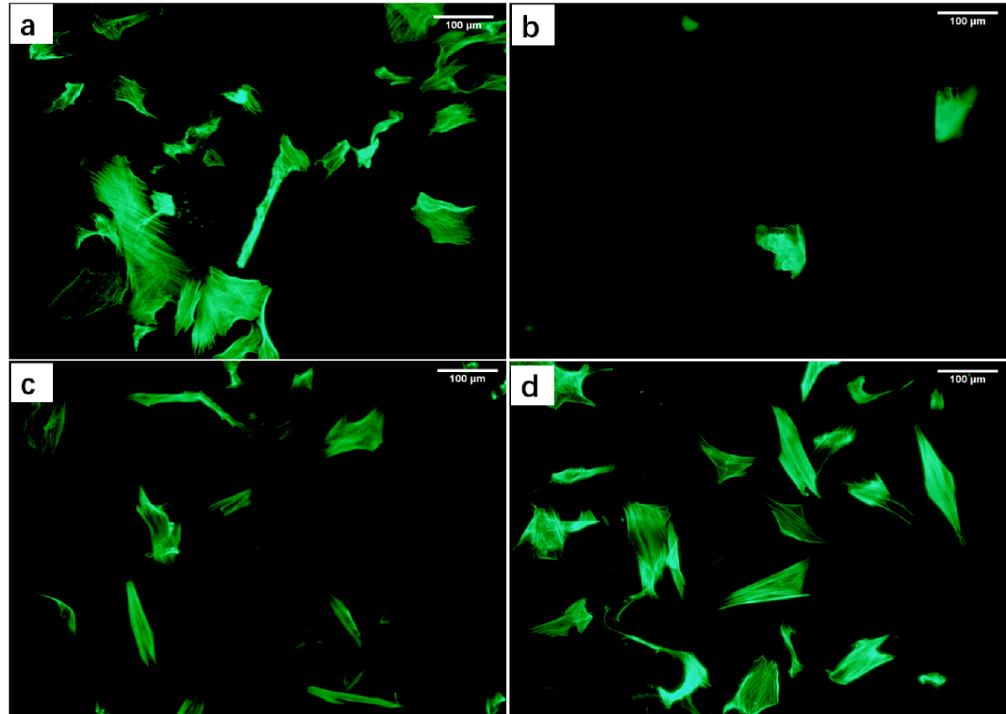
Figure 4. Morphology of DPCs in the extracted media of different scaffolds. Cell microfilaments staining images of DPCs cultured in extract for 2 days. ( a ) Blank group, ( b ) FCC, ( c ) AC, and ( d ) FA. Scale bars = 100 μm.